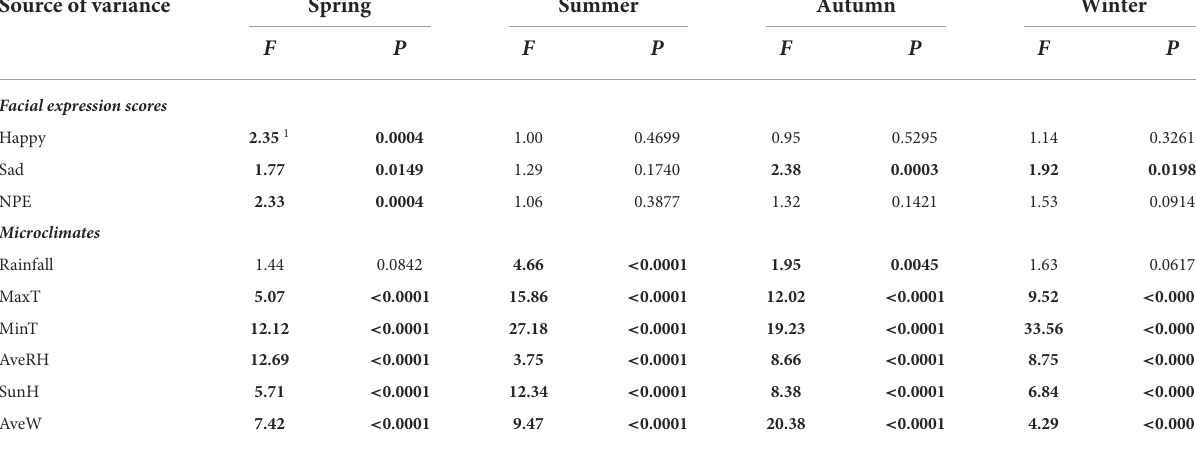
TABLE 3 ANOVA of different park variations on facial expression scores and microclimates in urban wetlands in cities of China. Source of variance Spring Summer Autumn